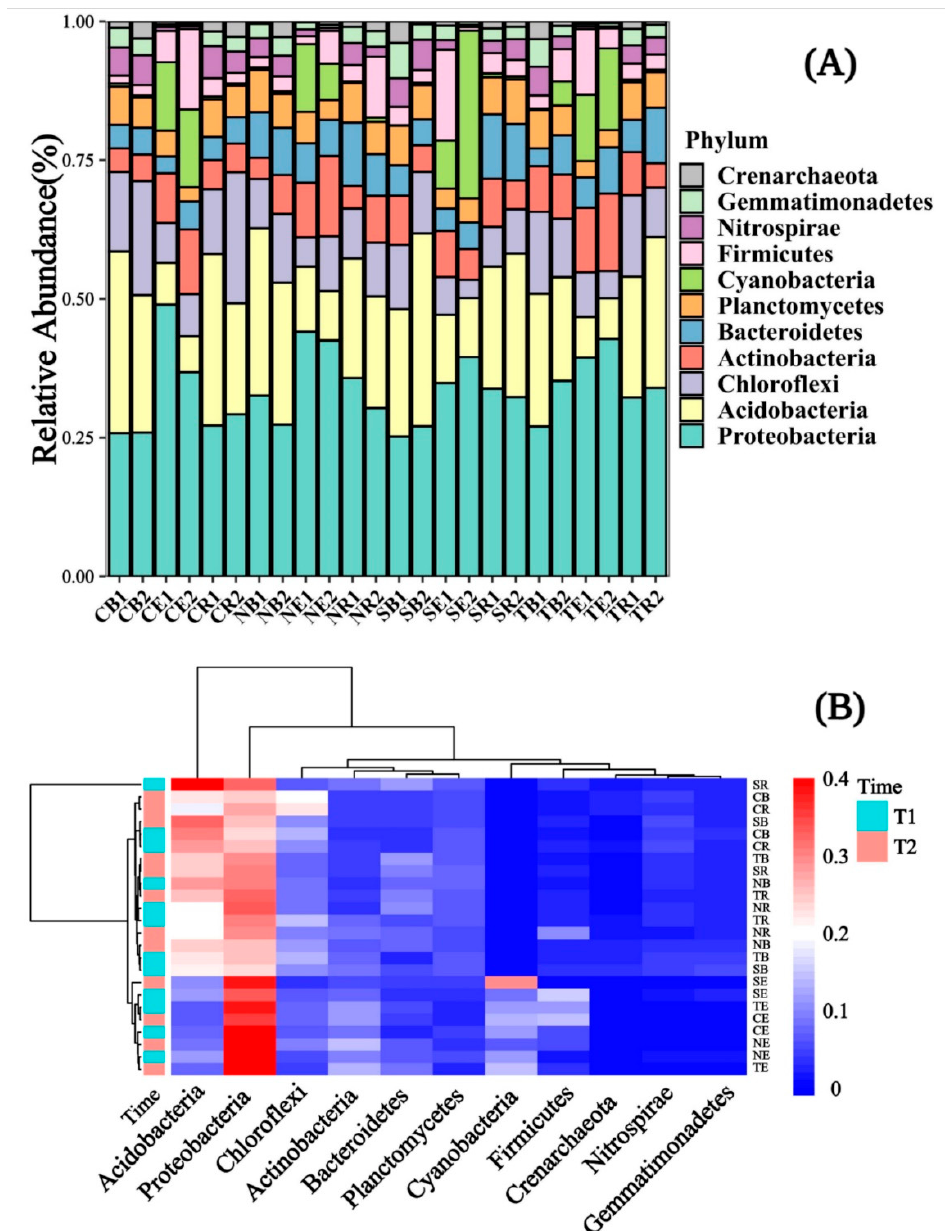
Figure 5. The relative abundance of soil microbial communities was shown with a bar chart and a clustering diagram responding in different emergence phases (T1 for early phase and T2 for late phase) within the riparian zones of the Three Gorges Dam Reservoir, China. Note: Abbreviations in the figures define as T1 (1), T2 (2) for ( A ) only, bulk soil ( B ), rhizosphere soil (R), endophyte (E), Cynodon dactylon (C), Hemarthria altissima (N), Salix matsudana (S), Taxodium distichum